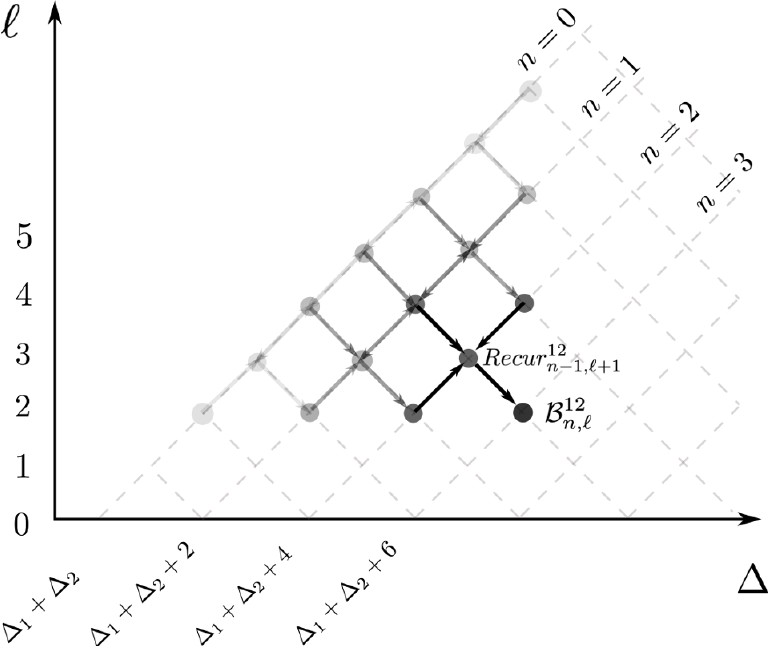
JHEP05(2019)006 Figure 1 . Illustration of the recursive algorithm for solving the OPE coe(cid:14)cient B 12 . The equation n;‘ Recur 12 = ~ a 12 solves B 12 in terms of B 12 , B 12 , B 12 and B 12 which n (cid:0) 1 ;‘ +1 n (cid:0) 1 ;‘ +1 n;‘ n (cid:0) 1 ;‘ n (cid:0) 1 ;‘ +1 n (cid:0) 1 ;‘ +2 n (cid:0) 2 ;‘ +2 have smaller values of n . This procedure is iterated until one reaches the n = 0 data which are the seed coe(cid:14)cients one inputs. Figure 2 . Illustration of the constraints on B 12 , B 12 , . . . , B 12 imposed by the equation 0 ; 0 0 ; 1 0 ; 2 n +1 Recur 12 = ~ a 12 n; 0 n; 0